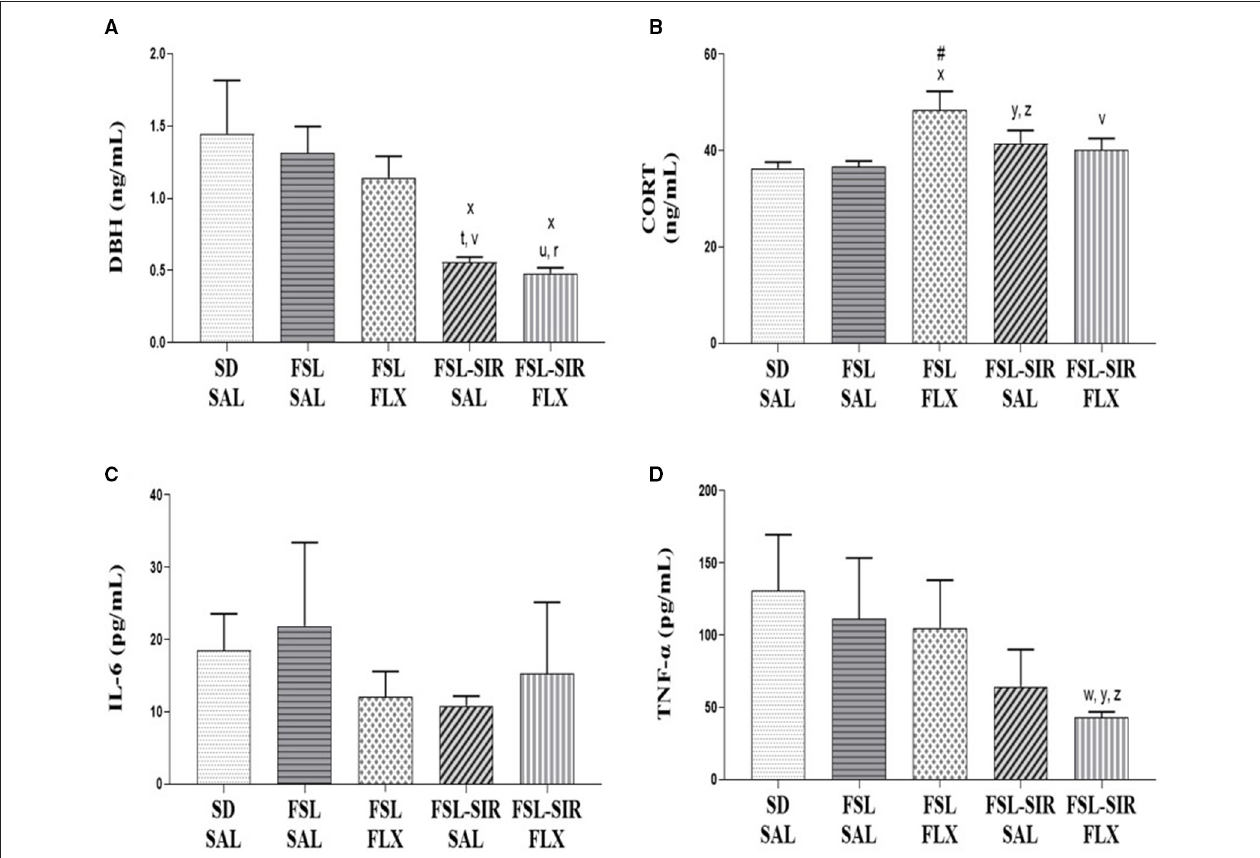
FIGURE 6 | Plasma biochemistry. (A) DBH. x p < 0.05 vs. SD-SAL; t d = 1.9, r d = 2.1 vs. FSL-SAL; v d = 1.8, u d = 2.0 vs. FSL-FLX. (B) CORT. x p < 0.05 vs. SD-SAL; # p < 0.05 vs. FSL-SAL; y d = 0.8 vs. SD-SAL; z d = 0.8 vs. FSL-SAL; v d = 0.8 vs. FSL-FLX. (C) IL-6. No significant effects between cohorts were observed. (D) TNF- α . y d = 1.1 vs. SD-SAL; w d = 0.8 vs. FSL-SAL; z d = 0.9 vs. FSL-FLX. Data were analysed using two-way ANOVA followed by Bonferroni post hoc test and Cohen’s d analysis. Data are presented as mean ± SEM. Detailed p –values in the text. CORT, corticosterone; DBH, dopamine-beta-hydroxylase; FSL, Flinders’ Sensitive Line; FLX, fluoxetine; IL-6, interleukin 6; SAL, saline; SD, Sprague-Dawley; SIR, social isolation rearing; TNF- α , tumour necrosis